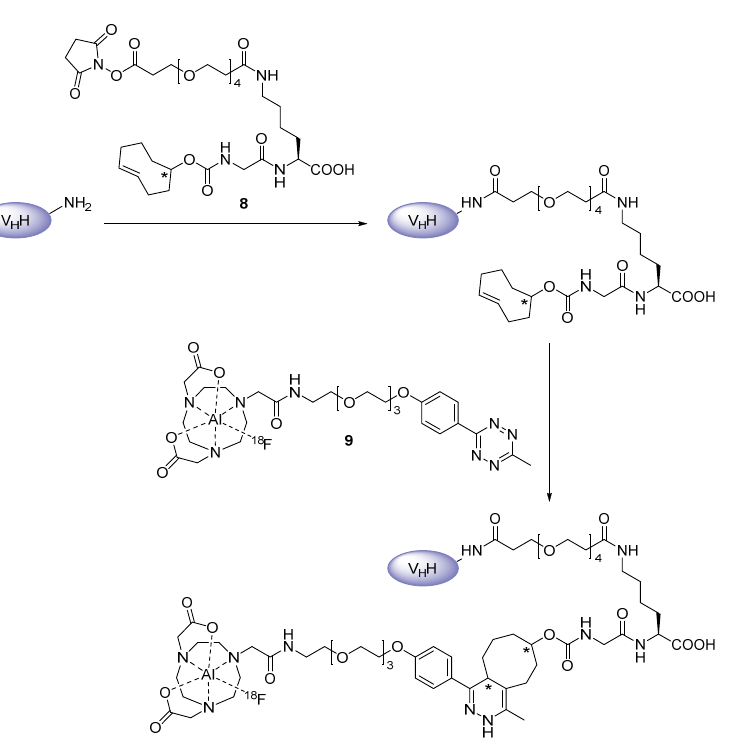
Figure 11. Pre-derivatization on primary amines of the nanobody with 8 , followed by 18 F-labeling with 9 via IEDDA reaction [15].